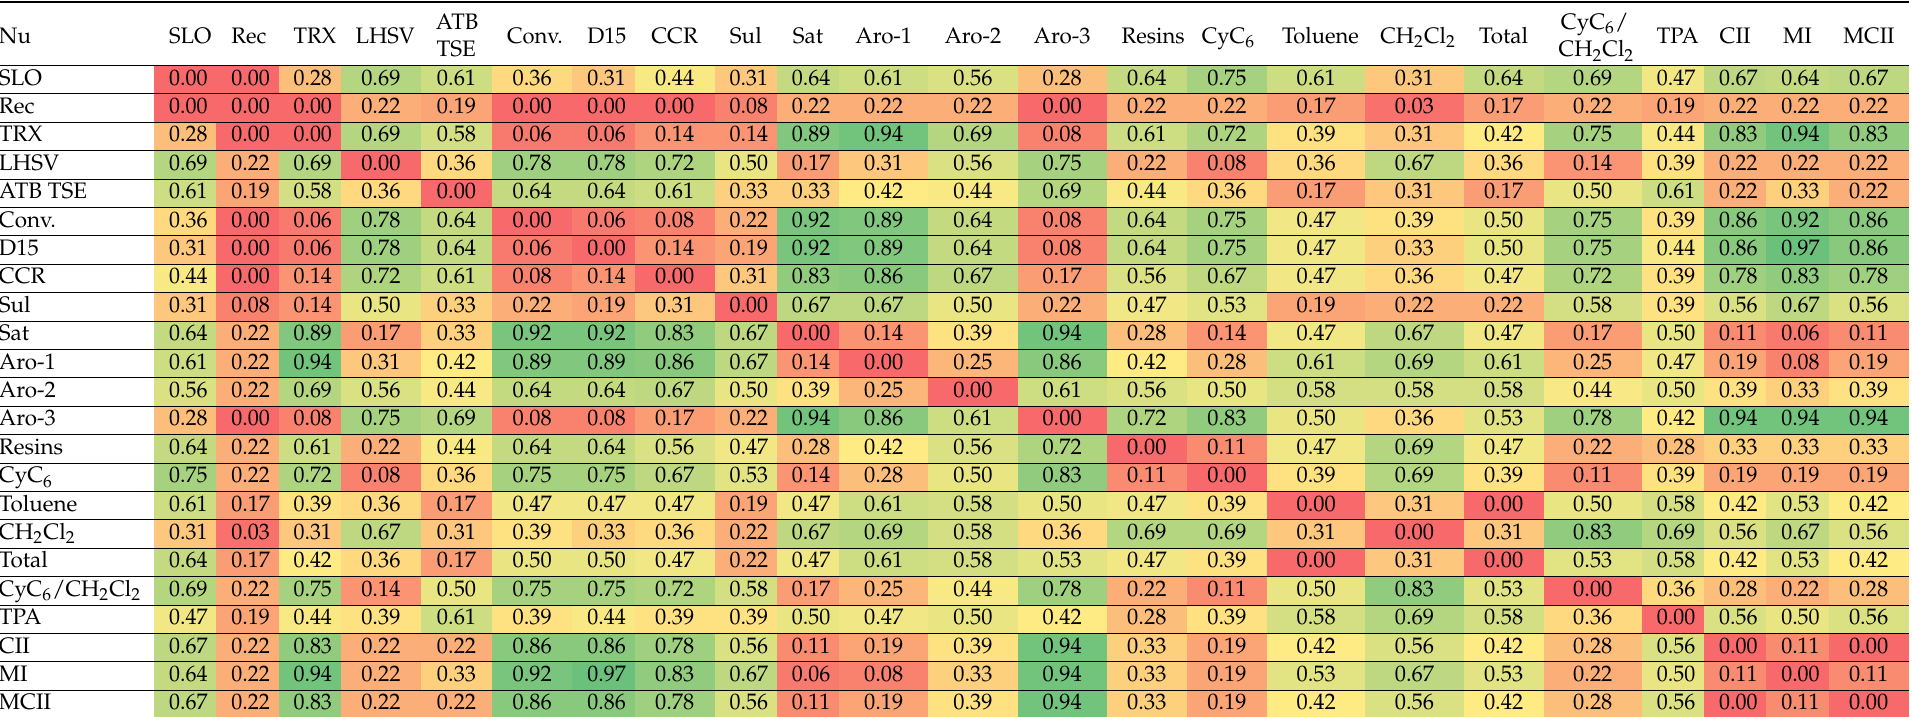
Table 4. υ -value of the ICrA evaluation of relations between bulk properties, SAR-AD characteristics of H-Oil VTB, and reaction severity. SLO = FCC slurry (%